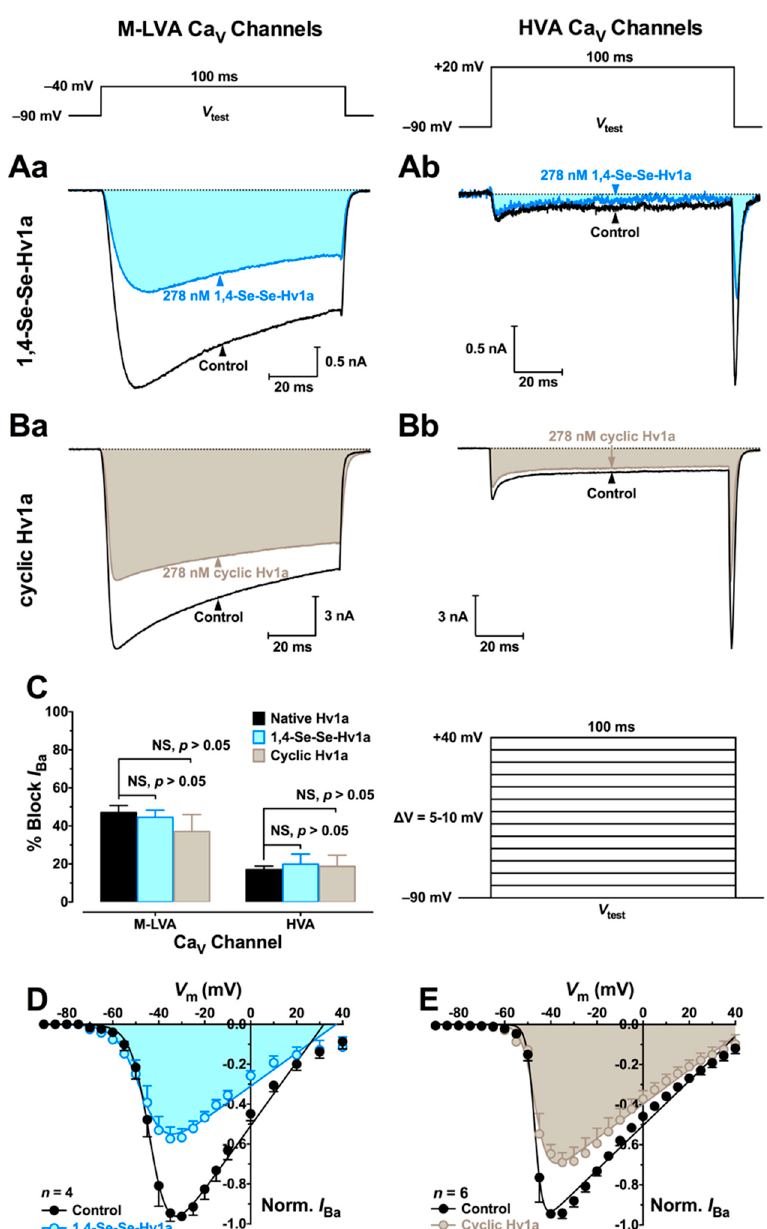
Figure 5. Effect of Hv1a and analogs on Ca V channels in cockroach dorsal unpaired median (DUM) neurons. ( A , B ) Typical effects of ( A ) 1,4-SeSe-Hv1a and ( B ) cyclic Hv1a on I Ba . Representative control (black) and toxin (cyan and shaded for 1,4-Se-Se-Hv1a, grey and shaded for cyclic Hv1a) traces elicited by a 100-ms depolarising test pulse ( V test ) to − 40 mV (left-hand ‘ a ’ panels; M-LVA Ca V channel currents) or +20 mV (right-hand ‘ b ’ panels; HVA Ca V channel currents). The dotted line represents zero current. Voltage protocols are shown above traces; ( C ) Comparison of average block of M-LVA and HVA I Ba by native Hv1a (black), 1,4-SeSe-Hv1a (cyan), and cyclic Hv1a (gray). Data are mean ± SEM ( n = 4–5). There were no significant differences between native Hv1a and either analog (two-way ANOVA, p > 0.05, n = 3–5); ( D , E ) Effect of ( D ) 1,4-SeSe-Hv1a and ( E ) cyclic Hv1a ( E ) on the voltage-dependence of Ca V channel activation. Ca V channel currents were elicited by the pulse protocol shown above panel ( E ); Currents recorded in the presence of toxin were normalised to the maximum inward I Ba in controls and fitted with Equation (1) (see Section 4.5). Data shows normalised I Ba before (closed circles) and after (open circles and shaded) application of toxin. Data are mean ± SEM ( n = 4–5).